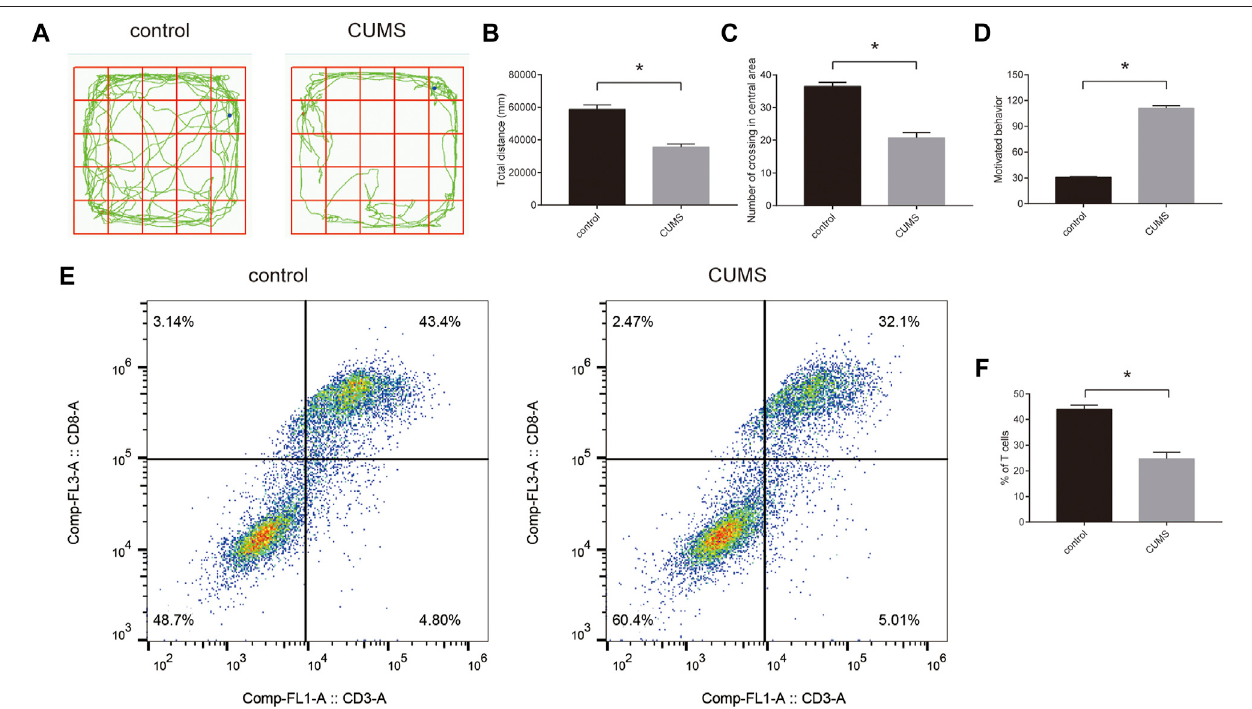
FIGURE 7 | The proportion of CD8 + T cells in the peripheral blood of rats in the CUMS model. (A – D) The stress behavior was evaluated by open fi eld experiment (A – C) and forced swimming test (D) . (E,F) The fl ow cytometric analysed the proportion of CD8 + T cells in the control groups and CUMS groups. Statistical analysis: unpairedt-tests.Dataarepresentedasthemean±SEM( n =6pergroup).* p < 0.05comparedtocontrol.Control:stress-freegroup.CUMS,chronicmildunpredictable stress